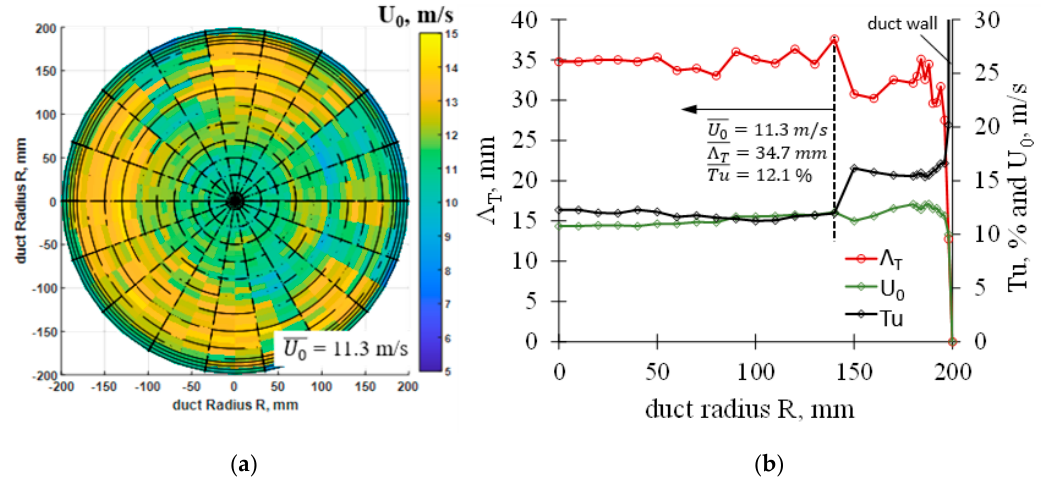
Figure 4. ( a ) Local distribution of longitudinal velocity; ( b ) Circumferentially averaged turbulent properties vs. the radial duct position for the tested turbulence grids at n = 2000 min − 1 , Tu = 12.1%, and measurement plane = rotor plane.